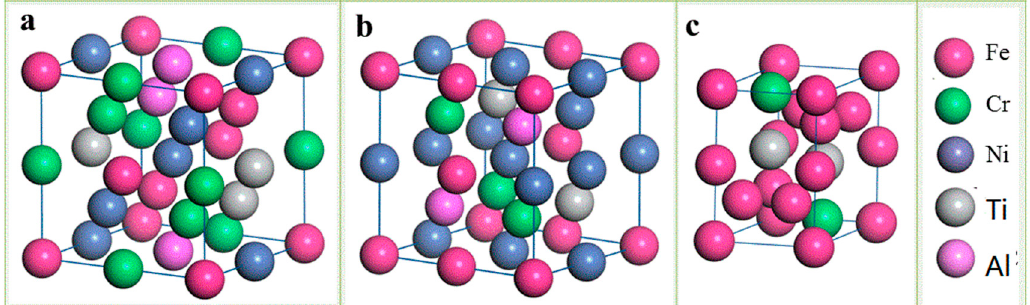
Figure 10. Gibbs free Energy calculation for Fe 25 Cr 25 Ni 25 Ti x Al (25 − x) multi-principal element alloys.